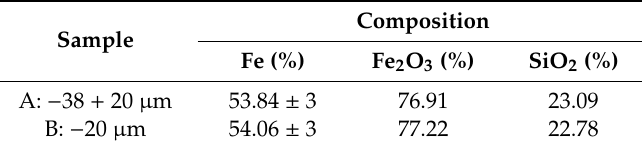
Table 1. Chemical analyses of iron ore sample.